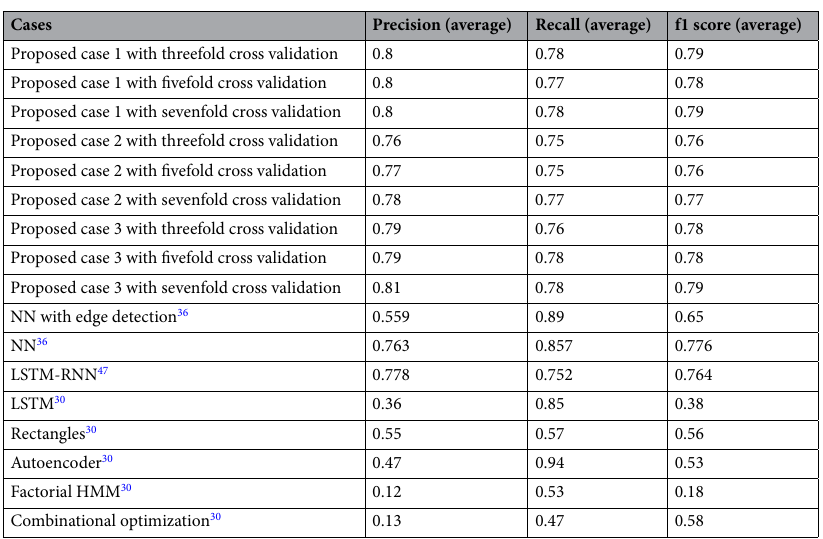
Table 8. Comparison of proposed cases with literature.